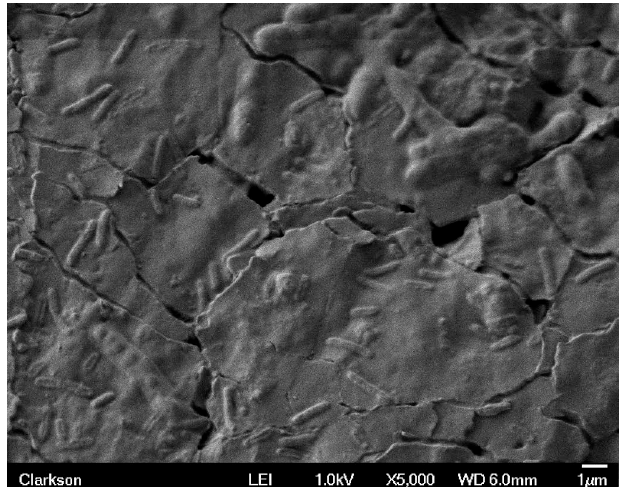
Figure 6. Sample 7 showing surface texture and separation of biofilm with visible bacteria.